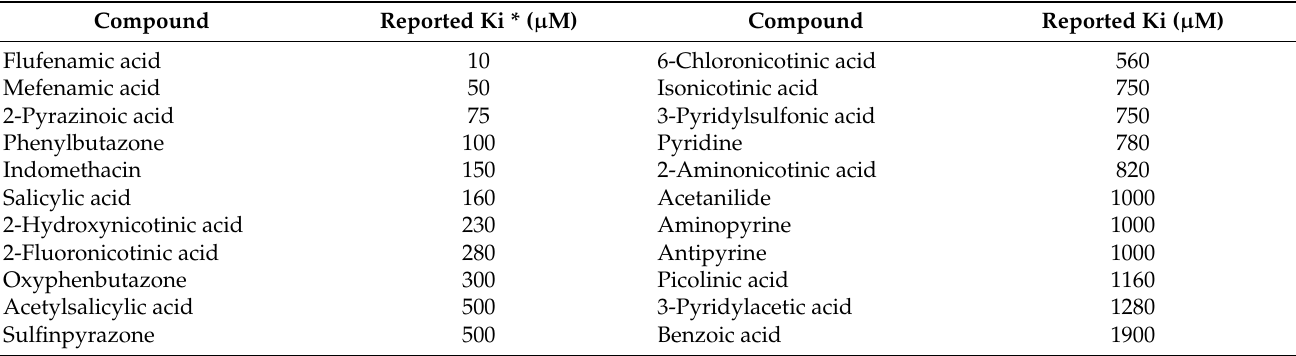
Table 1. Known inhibitors of human NAPRT